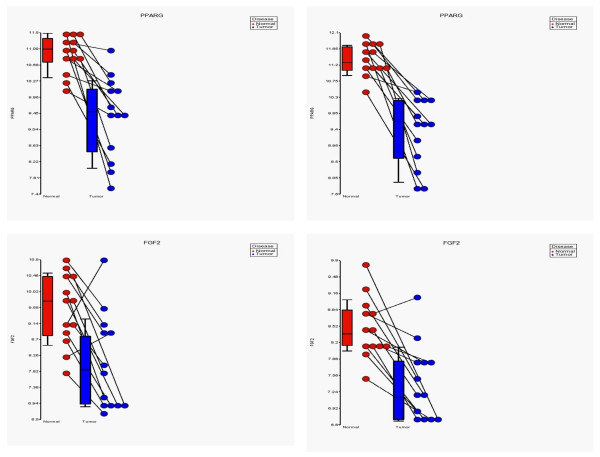
Dotplot for PPARG and FGF2 in FF and FFPE samples. Dot plots for "PPARG" are shown in upper panel and that of "FGF2" in the lower panel. In each panel data from FF samples are shown on the left plot and that of FFPE is shown on the right plots. In each dot plot, corresponding samples are joined by straight lines (indicating same patient), the gene expression in normal tissue is shown in red on left side and that of tumor tissue is shown in blue on right side of each dot plot. Each box extends from 25th to 75th centile with a central mark for 50th centile; the whiskers show 10th and 90th centile for each set of data.